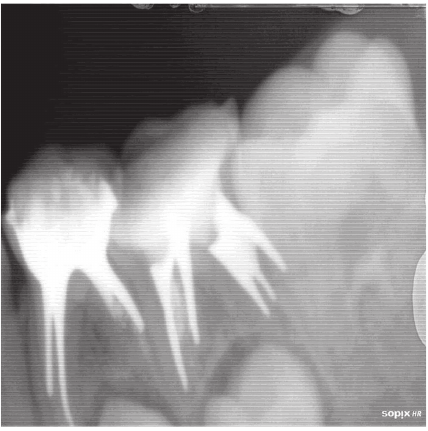
Figure 2: Canals obturated with Metapex paste in 74 and 75 (RVG image).